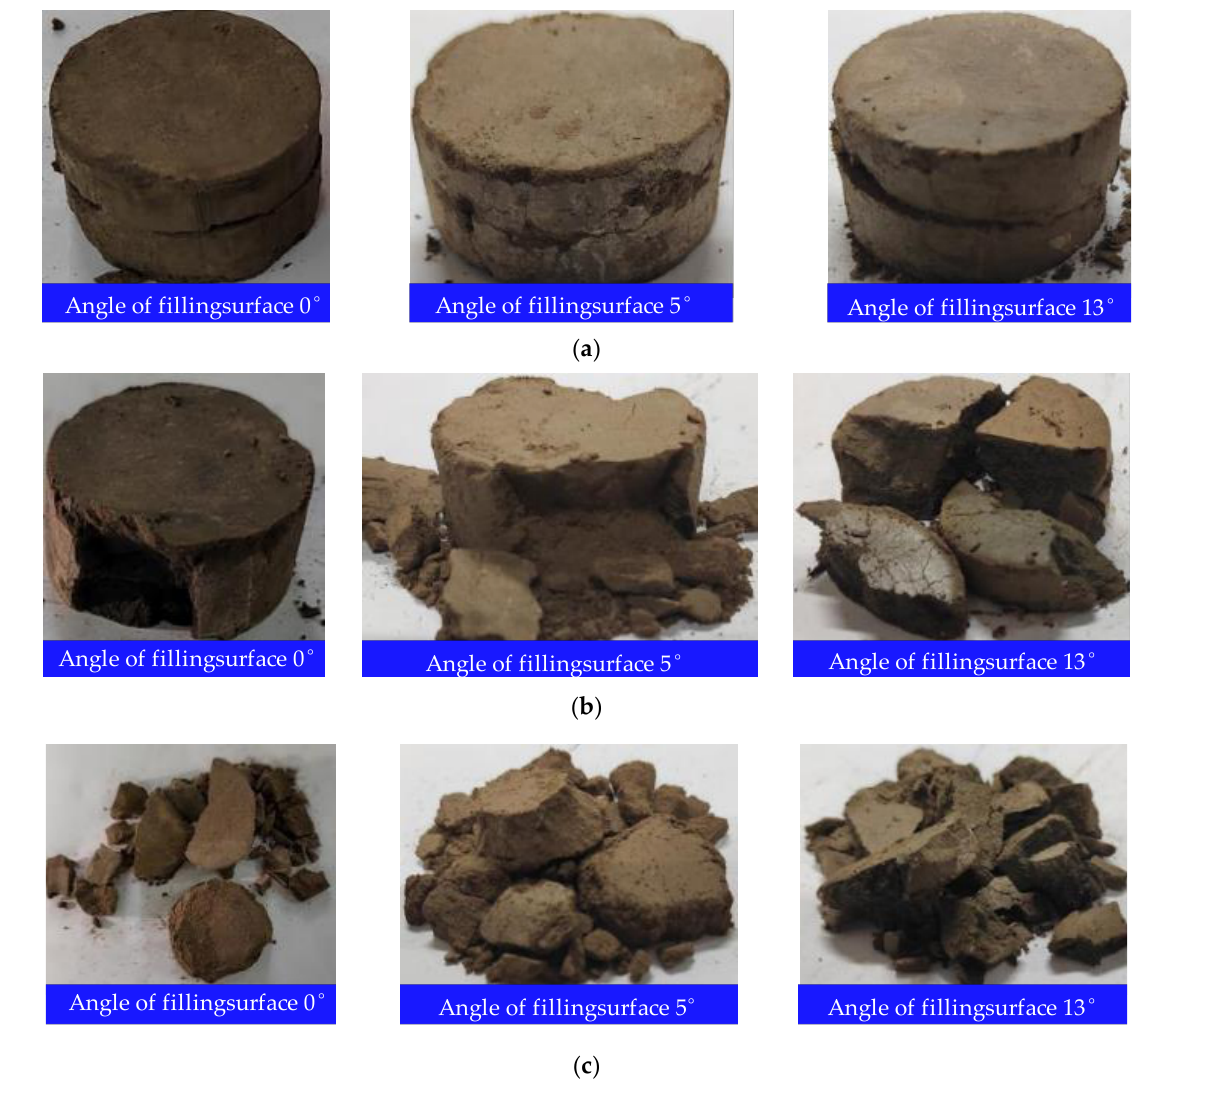
Figure 14. Influence of different filling surface angles on the failure mode of a layered filling body: ( a ) failure mode of layered filling body with approximate strain rate of 16 s − 1 ; ( b ) failure mode of layered filling body with approximate strain rate of 27 s − 1 ; ( c ) failure mode of layered filling body with approximate strain rate of 40 s − 1